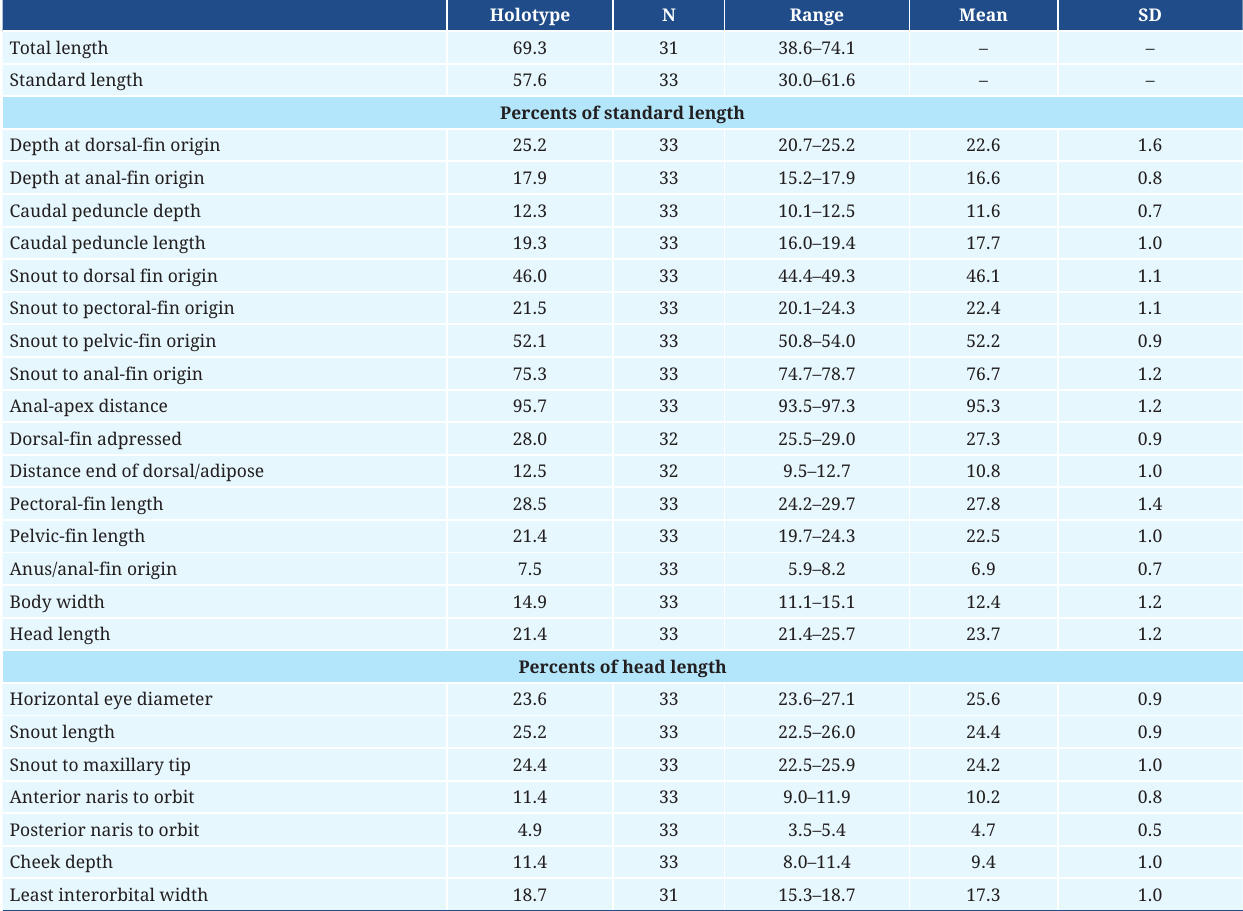
TABLE 1 | Morphometric data of holotype and paratypes of Characidium krenak , range includes the holotype. N = total number of specimens examined; SD = Standard